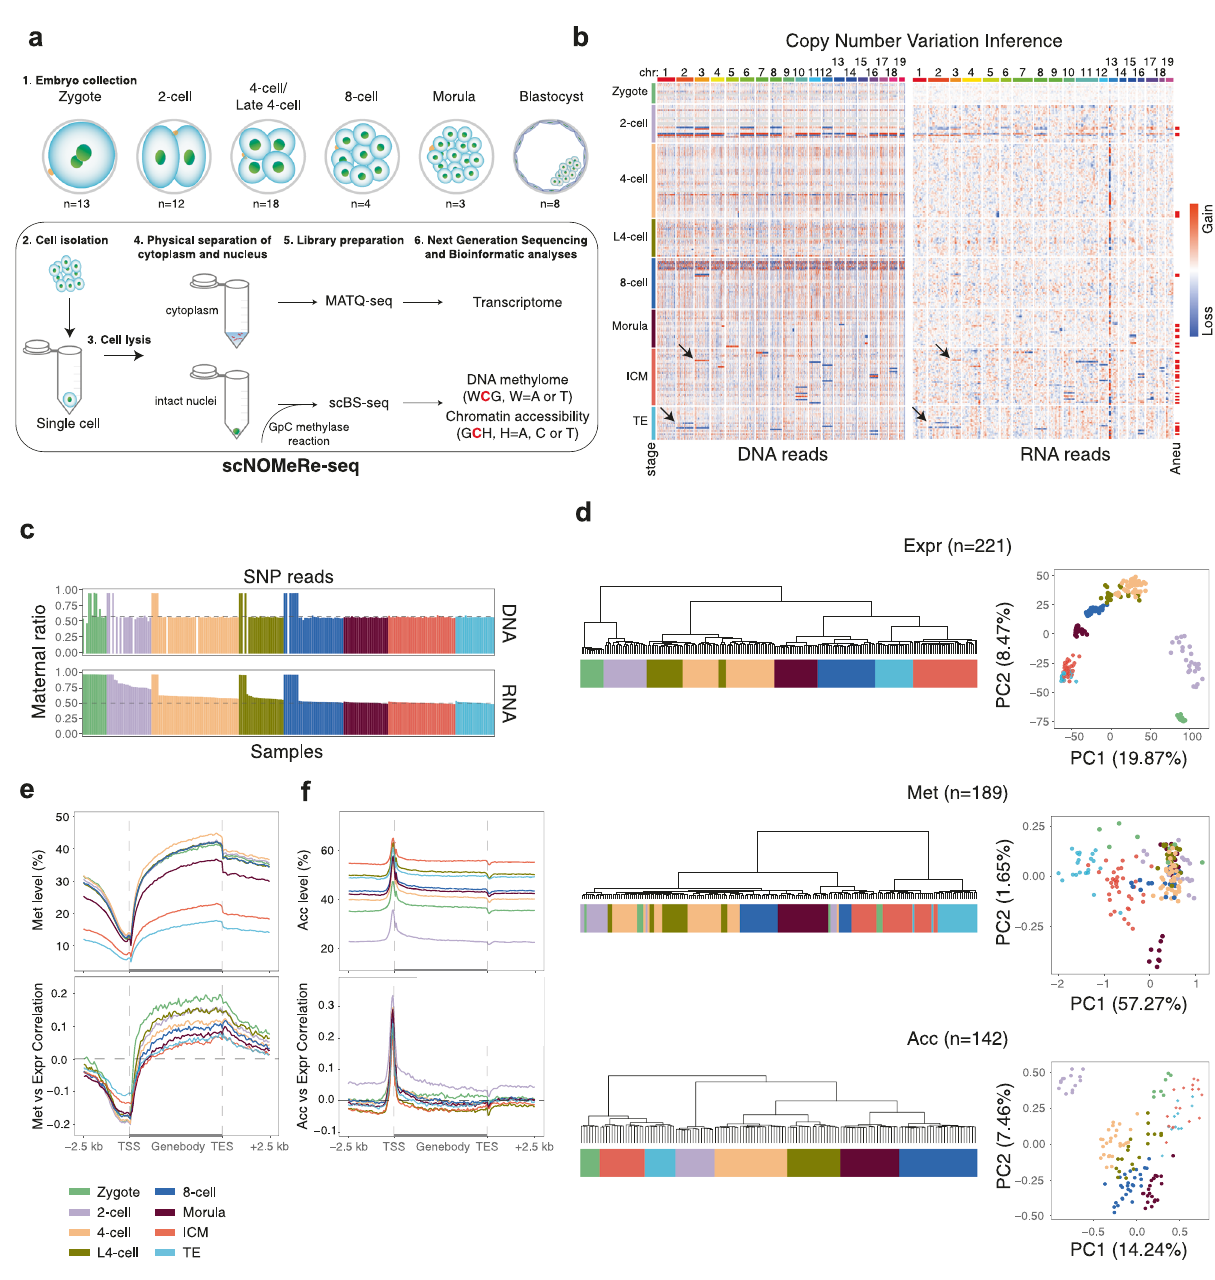
Fig. 1 scNOMeRe-seq pro fi les in mouse preimplantation embryos. a Schematic illustration of scNOMeRe-seq, including key steps, methods of library preparation, mouse preimplantation stages analyzed in this work and embryo numbers ( n ) outlined in the text. b Heat map showing copy number variations (CNV) inferred by DNA reads (left) and gene expression level (right, normalized each gene by average closest 100 genes) in mouse preimplantation blastomeres. Arrows indicate the examples of matched CNV inferences from DNA and RNA reads. c Bar plot showing the ratios of SNP tracked maternal DNA (top) or RNA (bottom) reads in total SNP tracked parental reads in each individual cell across preimplantation development. d Unsupervised clustering (left) and principle component analysis (right) of preimplantation blastomeres using gene expression level (top), DNA methylation level of 5 kilobases (kb) tiles (middle) and chromatin accessibility of all stage merged NDRs (bottom). n, the cell numbers of each dataset. e Pro fi les showing DNA methylation level (top), the weighted Pearson correlation coef fi cients of DNA methylation level vs gene expression level (bottom) along the gene bodies and 2.5kb upstream of the transcription start sites (TSS) and 2.5kb downstream of the transcription end sites (TES) of all genes for each stage. Met, WCG methylation; Expr, RNA expression. f Pro fi les showing chromatin accessibility (top), the weighted Pearson correlation coef fi cients of chromatin accessibility vs gene expression level (bottom), along the gene bodies and 2.5 kb upstream of the TSS and 2.5 kb downstream of the TES of all genes for each stage. Acc, GCH